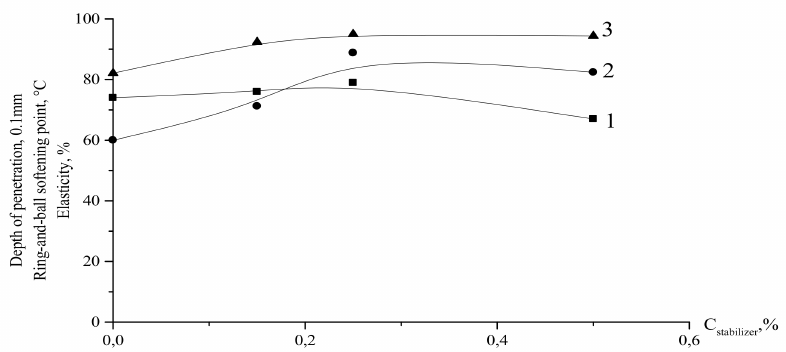
Figure 5. Dependence of depth of penetration (1), ring and ball softening point (2), elasticity (3) on stabilizer concentration.